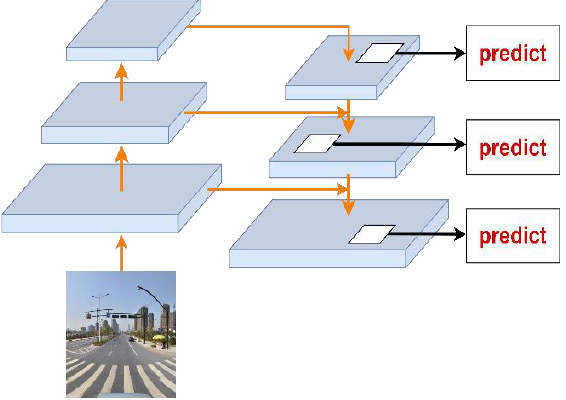
Figure 3. The network structure of FPN.